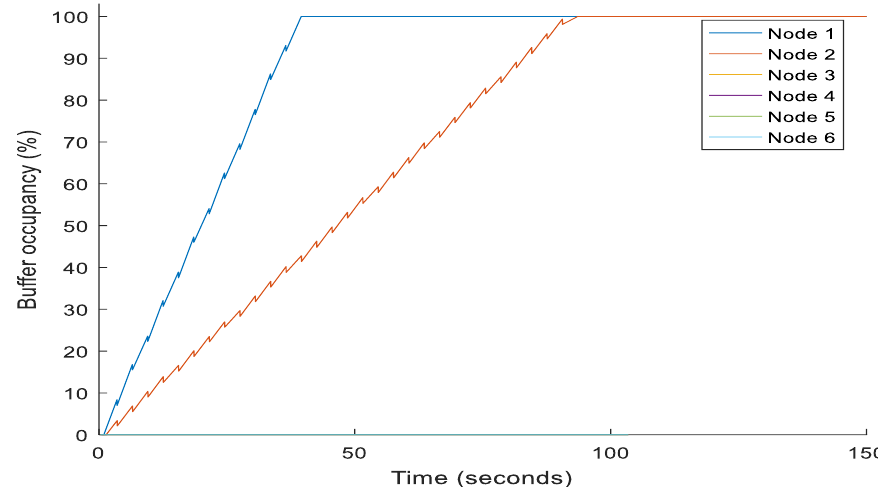
Figure 6. Buffer occupancy with NoDCCP at 0.1 Mbps.